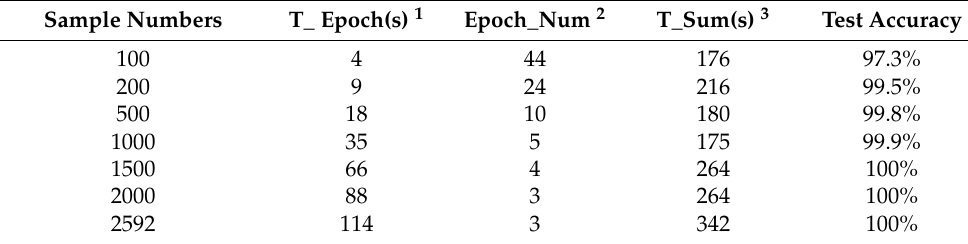
Figure 13. Result comparison. ( a ) Accuracy of training and ( b ) loss rate comparison. Table 8. Test Results